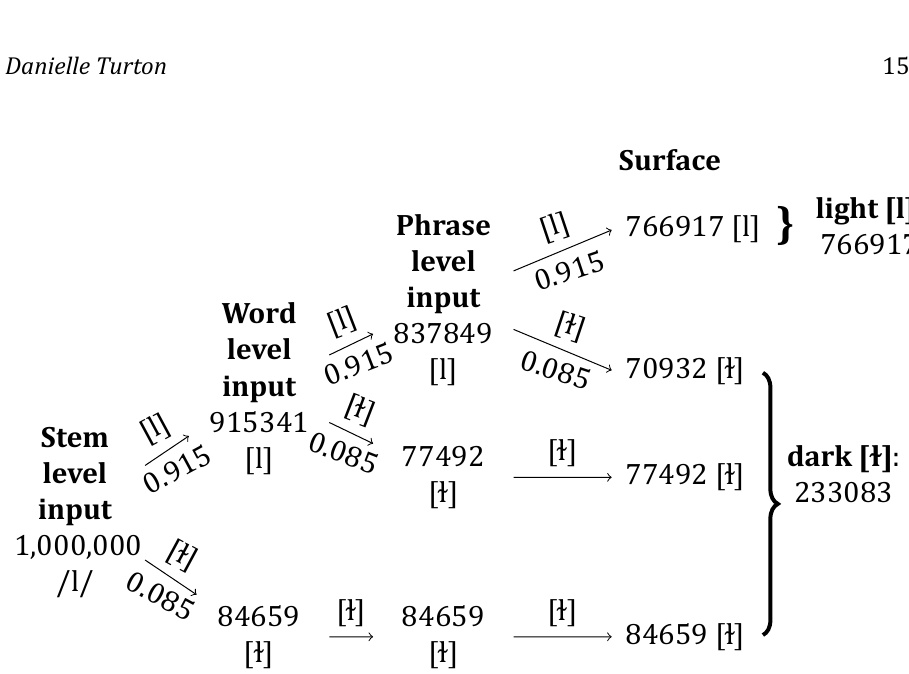
Figure 3: Tree demonstrating foot-based darkening in environment yellow (note that some numbers are presented as rounded but calculations are based on actual